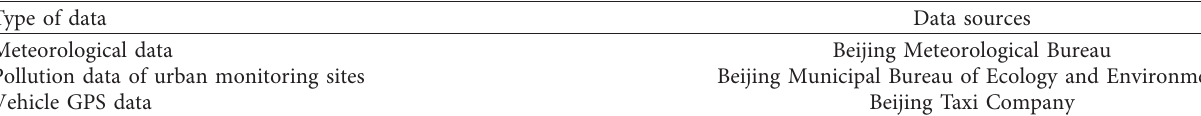
Figure 11: A case of external pollutant process from the southwest. Table 5: Data type and source.